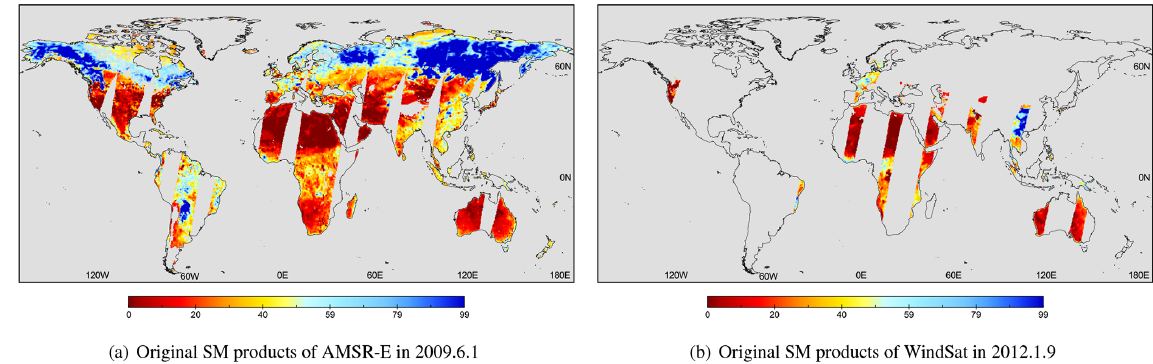
Figure 1. Daily soil moisture products of AMSR-E and